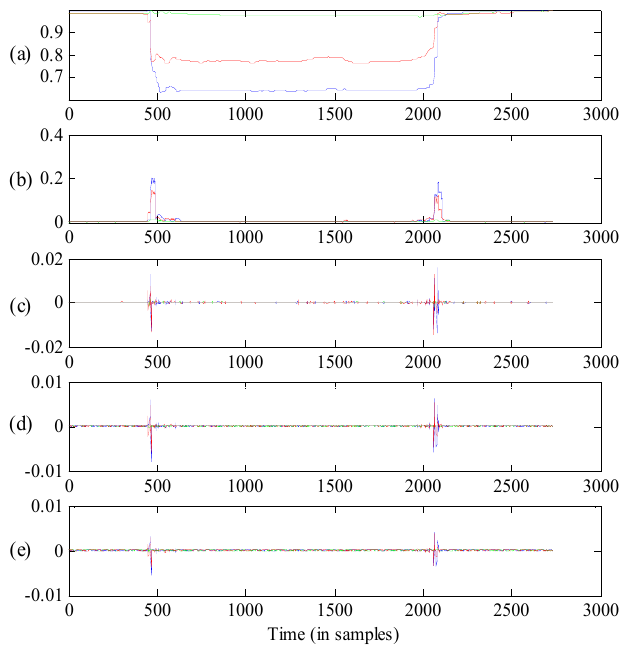
Figure 4. The results of MRSVD. ( a ) Voltage magnitude; ( b ) Singular value of the approximation; ( c – e ): Detail components at the first, second, and third levels, respectively.